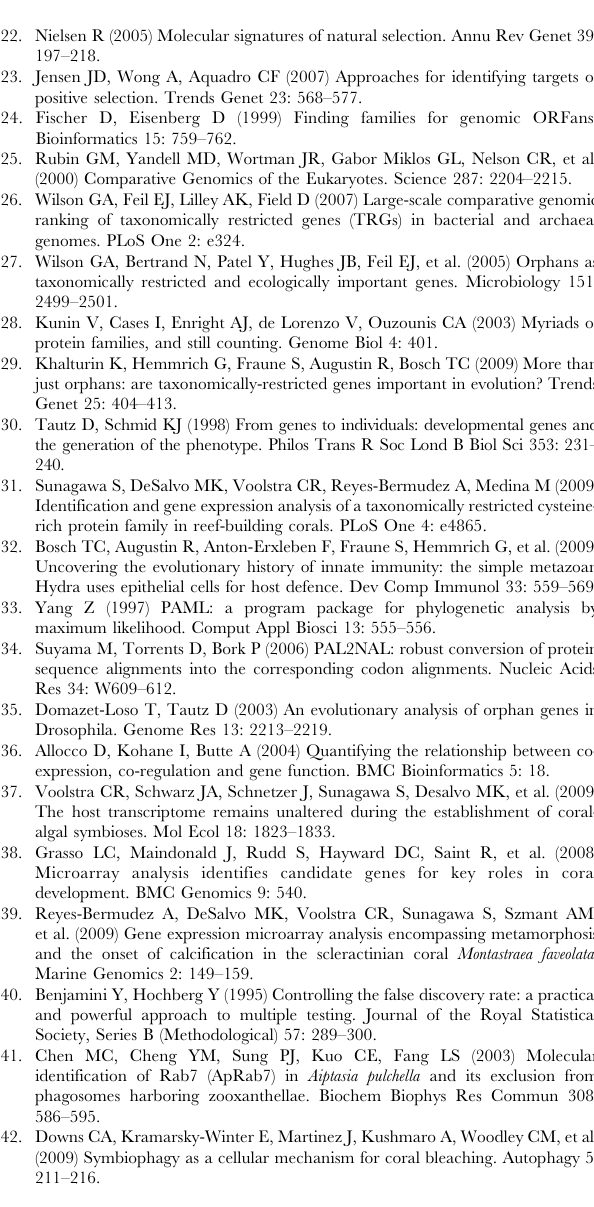
GO category indicates the number of orthologs assigned to this category in our dataset. Table S1 List of biological process GO categories most strongly enriched with orthologs (false discovery rate 10%) displaying elevated d N /d S and their assigned orthologs. Table S2 List of molecular function GO categories most strongly enriched with orthologs (false discovery rate 10%) displaying elevated d N /d S and their assigned orthologs. Table S3 Orthologs of A. millepora and A. palmata with associated pairwise d N /d S estimates.